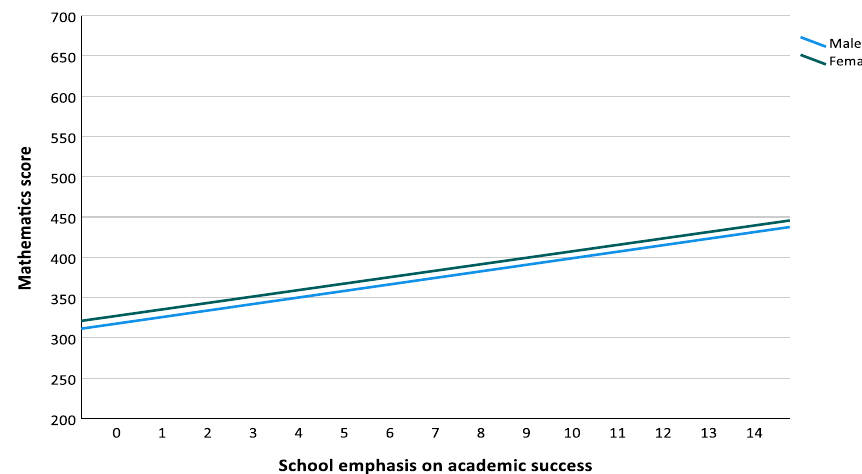
Fig. 8 Interaction between gender and school emphasis on academic success on mathematics achievement, grade 8. The plot presents the predicted values from step 7 of the mathematics model